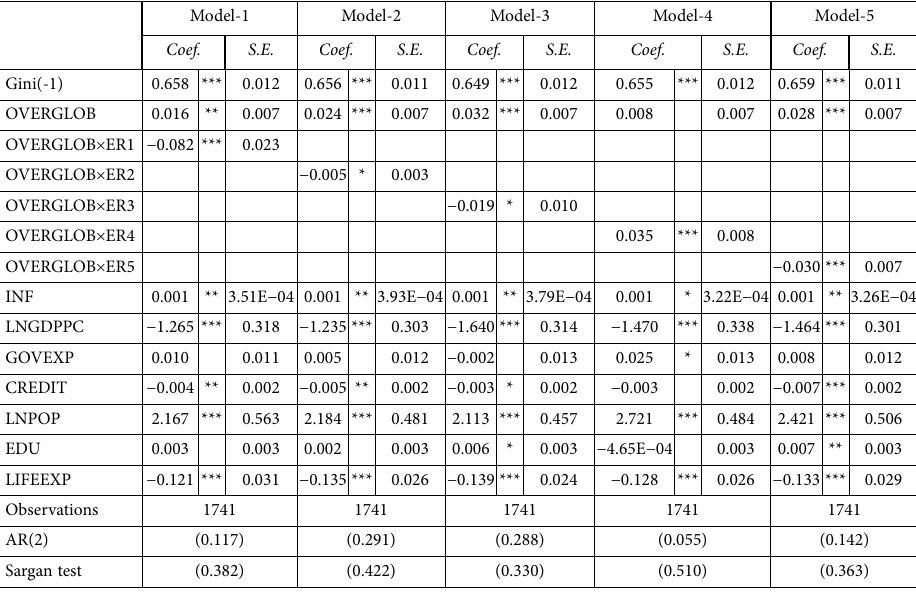
Table 6. The effects of globalization under sub-dimensions of economic risk Model-1 Model-2 Model-3 Model-4 Model-5